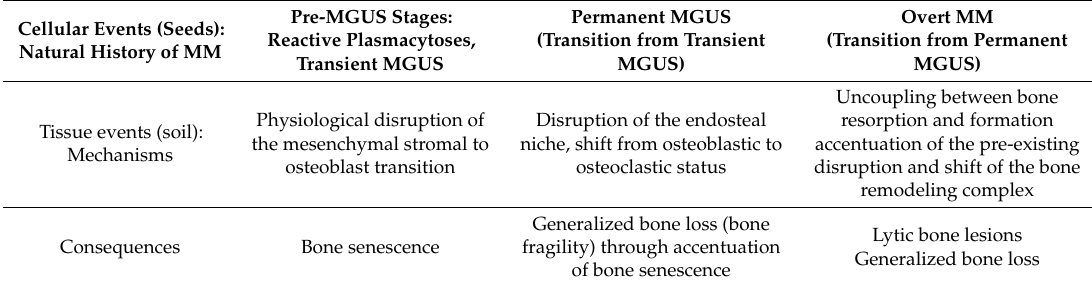
Table 3. Cellular and tissue events favoring a microenvironmental-based model of MM. Cellular Events (Seeds): Natural History of